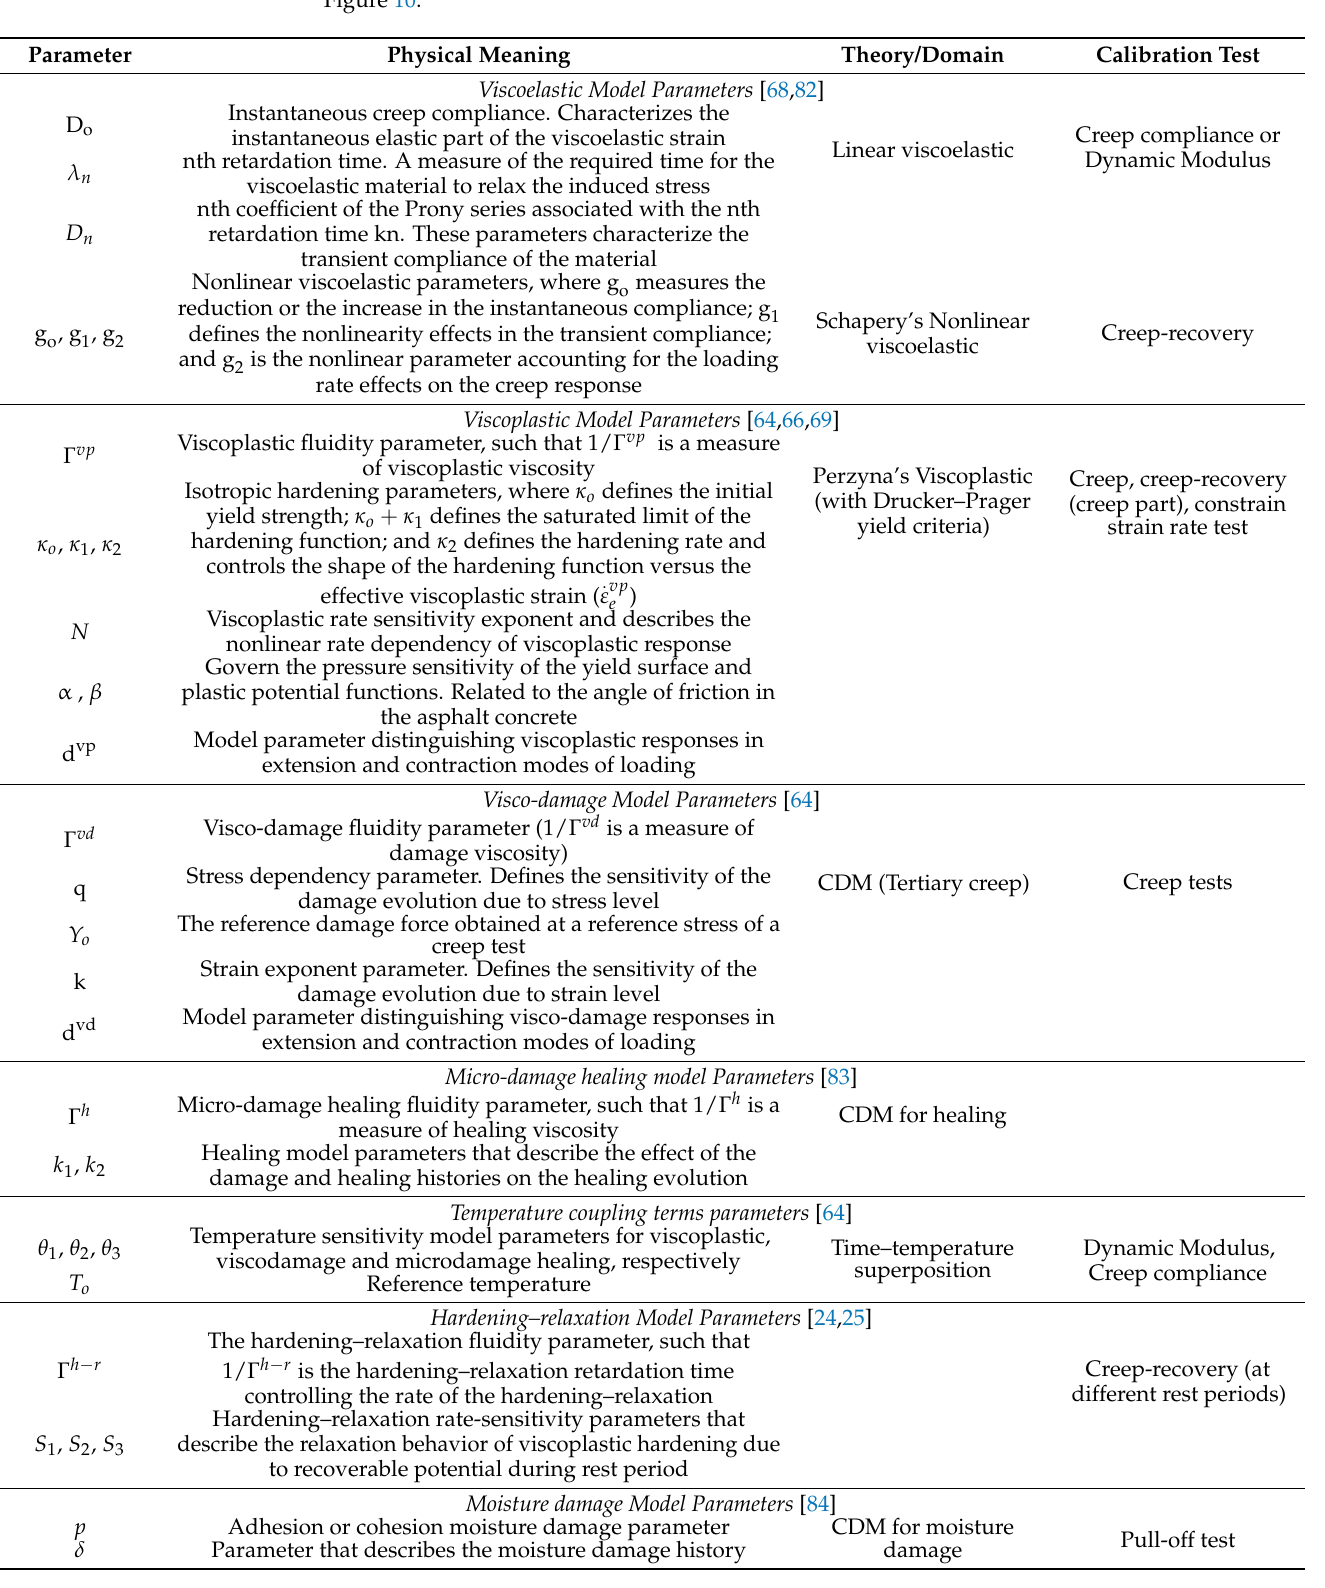
Table 2. Summary of material parameters of the constitutive equations and physical meaning in Figure